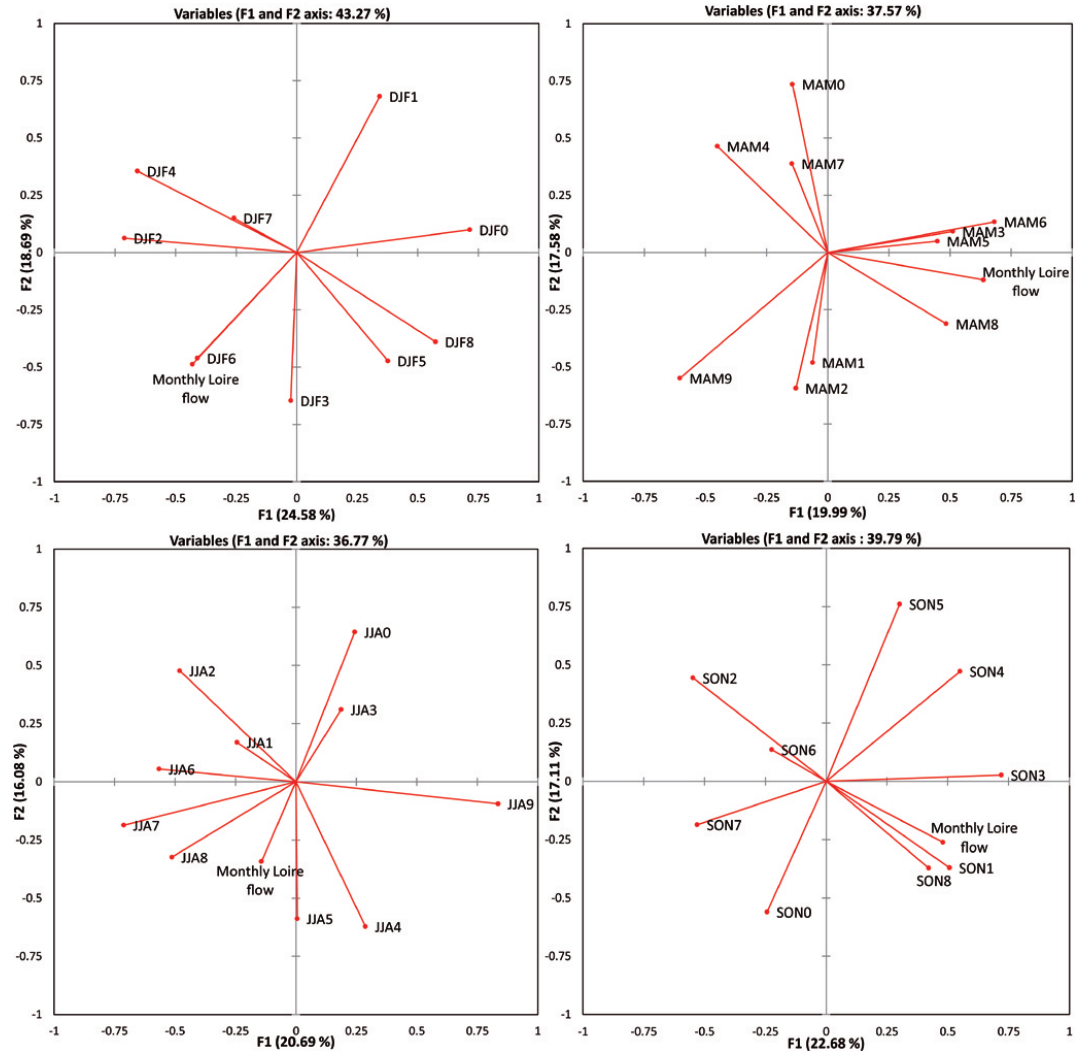
Fig. 9. Relationship between monthly Loire river flows and the occurrence of WTs with the PCA